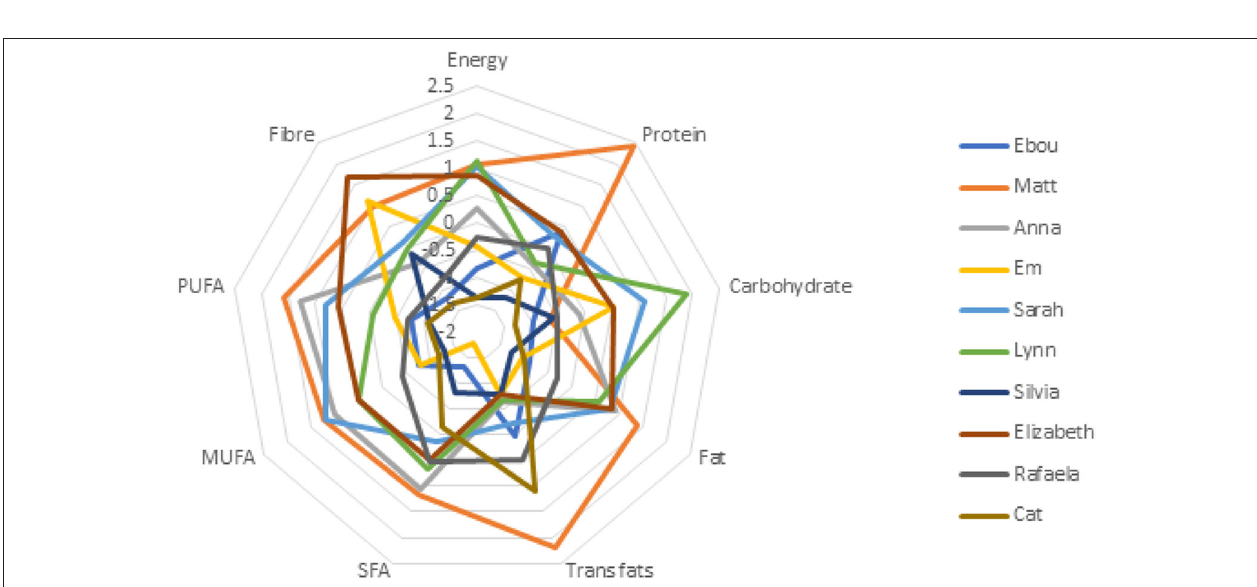
Multidimensional Body-Self Relations Questionnaire Body Areas Satisfaction.